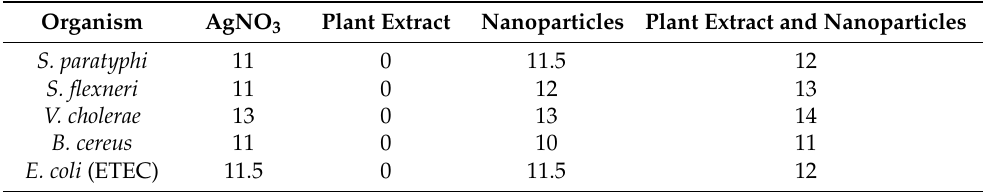
Table 1. Zone of inhibition of different organisms (all measurements indicated are in mm). Organism AgNO 3 Plant Extract Nanoparticles Plant Extract and